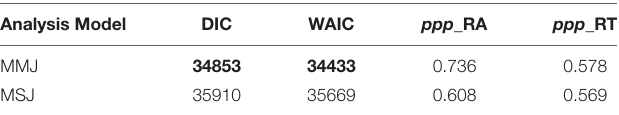
TABLE 10 | Model fit for the PISA 2012 computer-based mathematics data. Analysis